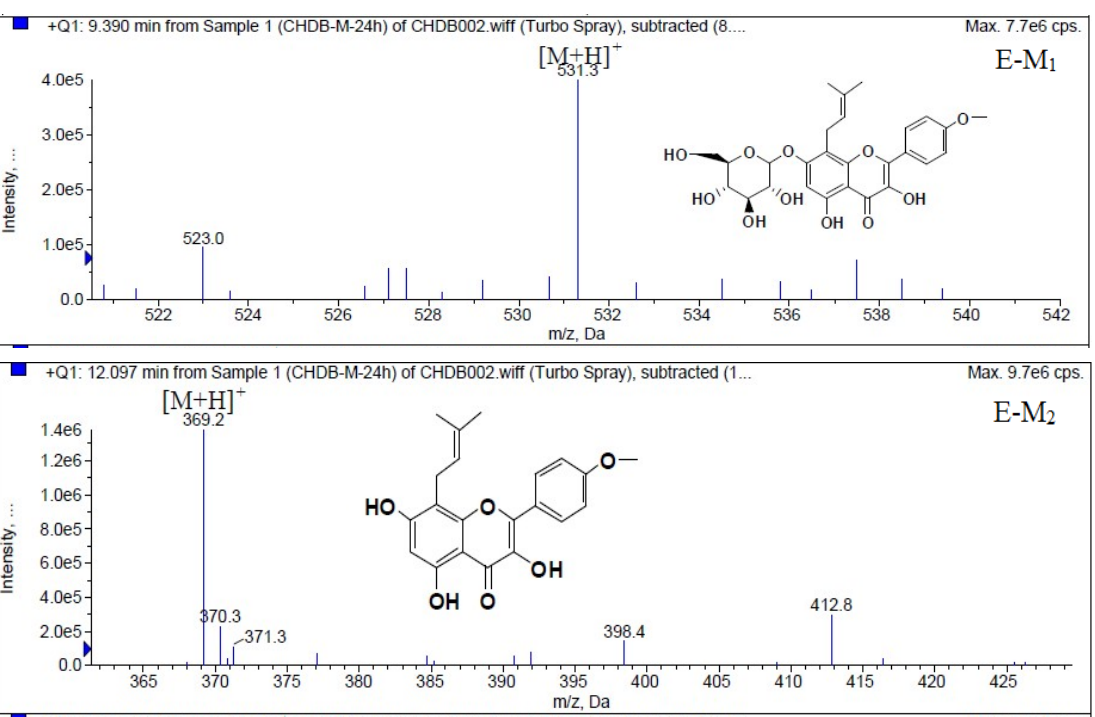
Figure 8. Mass spectra of metabolite of epimedin B. E for metabolites in intestinal enzyme; F for metabolites in intestinal